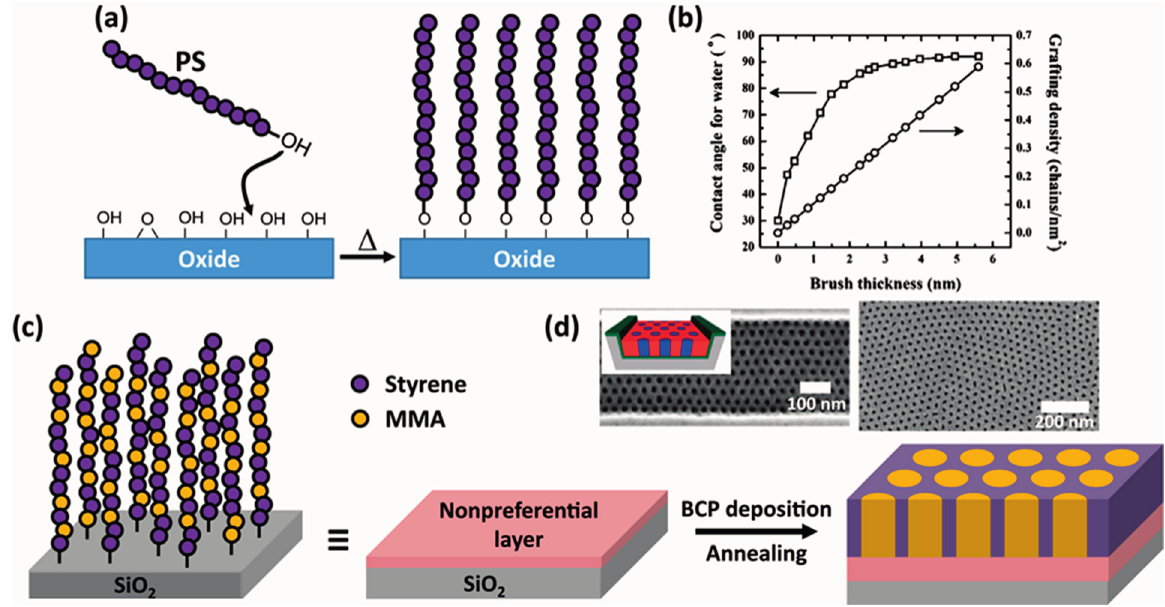
Figure 2. ( a ) Thermally induced solid state reaction for PS brush covalently bound to oxide surface; ( b ) Water contact angle and the grafting density for a series of PS brushes as a function of brush thickness showing effective control of surface energy by controlling grafting density (Reproduced with permission from Reference [39], Copyright 2011, Royal Society of Chemistry); ( c ) Creating random copolymer brush layer by thermal grafting to control wetting behavior and hence, the orientation of block copolymer; and ( d ) Top-down Scanning Electron Microscope (SEM) images of perpendicularly oriented PMMA domains (block dots in SEM images) in P(S- b -MMA) (poly(styrene- block -methyl methacrylate)) thin film on graphoepitaxial and planar substrates grafted with random copolymers. Schematic inset shows well-aligned vertically oriented PMMA cylinderss (blue) in PS matrix (red) in polymer brush (green) grafted graphoepitaxial channel (Reproduced with permission from Reference [40], Copyright 2014, Royal Society of